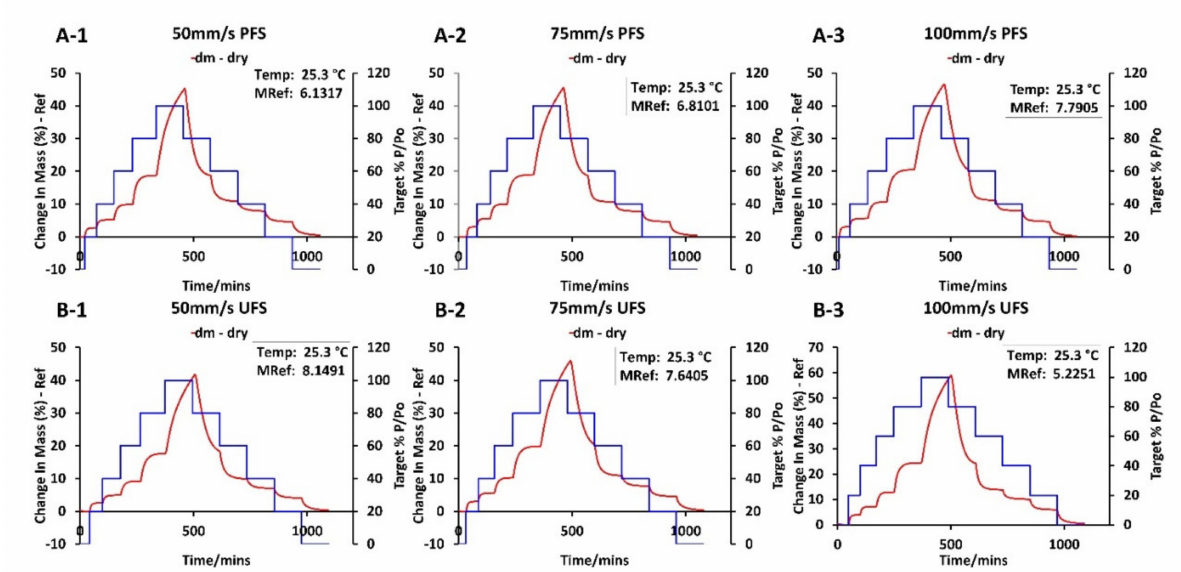
Figure 7. Dynamic Vapor Sorption of SLS 3D printed tablets from PFS and UFS ( A-1 ) 50 mm/s PFS, ( A-2 ) 75 mm/s PFS, ( A-3 ) 100 mm/s PFS, ( B-1 ) 50 mm/s UFS, ( B-2 ) 75 mm/s UFS, ( B-3 ) 100 mm/s